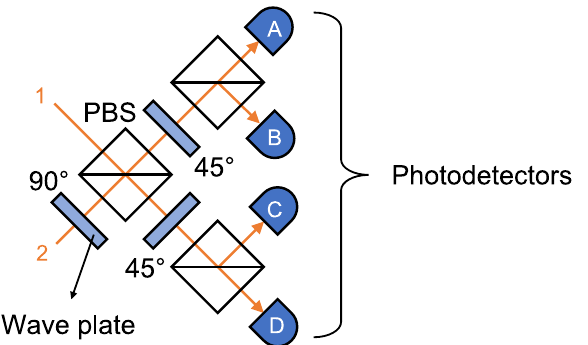
Fig. 2 BSM scheme for single-photon polarization qubits. A BSM uses three polarizing beam splitters (PBSs), 90 ∘ and 45 ∘ wave plates, and four (A--D) photodetectors (single-photon resolving or on-off detectors). A PBS transmits (re fl ects) photons polarized horizontally (vertically). The scheme distinguishes ψ ± j i : ψ þ